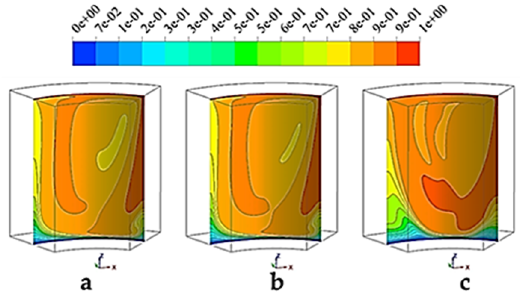
Figure 6. Isotherm lines of the middle plane for different Rayleigh numbers at the Re = 100, Ra = 1e4 and HR = 2. ( a ) ϕ = 0%, ( b ) ϕ = 1%, ( c ) ϕ = and HR = 2. ( a ) φ = 0%, ( b ) φ = 1%, ( c ) φ = 5%.